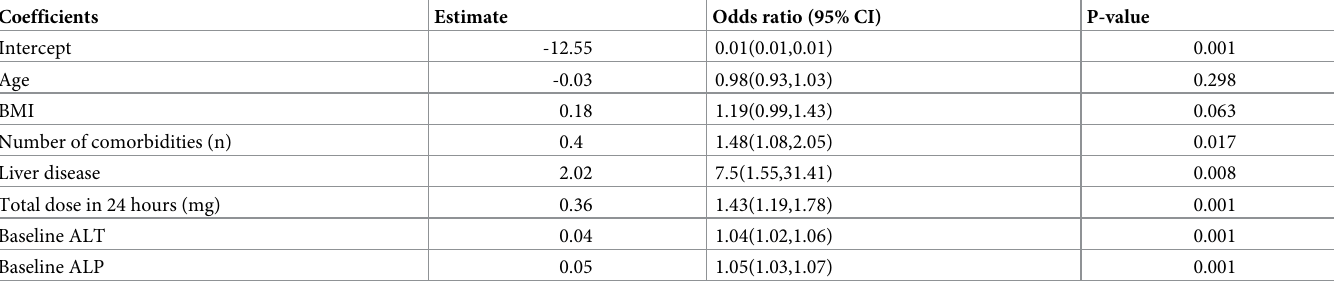
Table 5. Model 2: Multiple logistic-regression results relating the factors of drug-induced liver